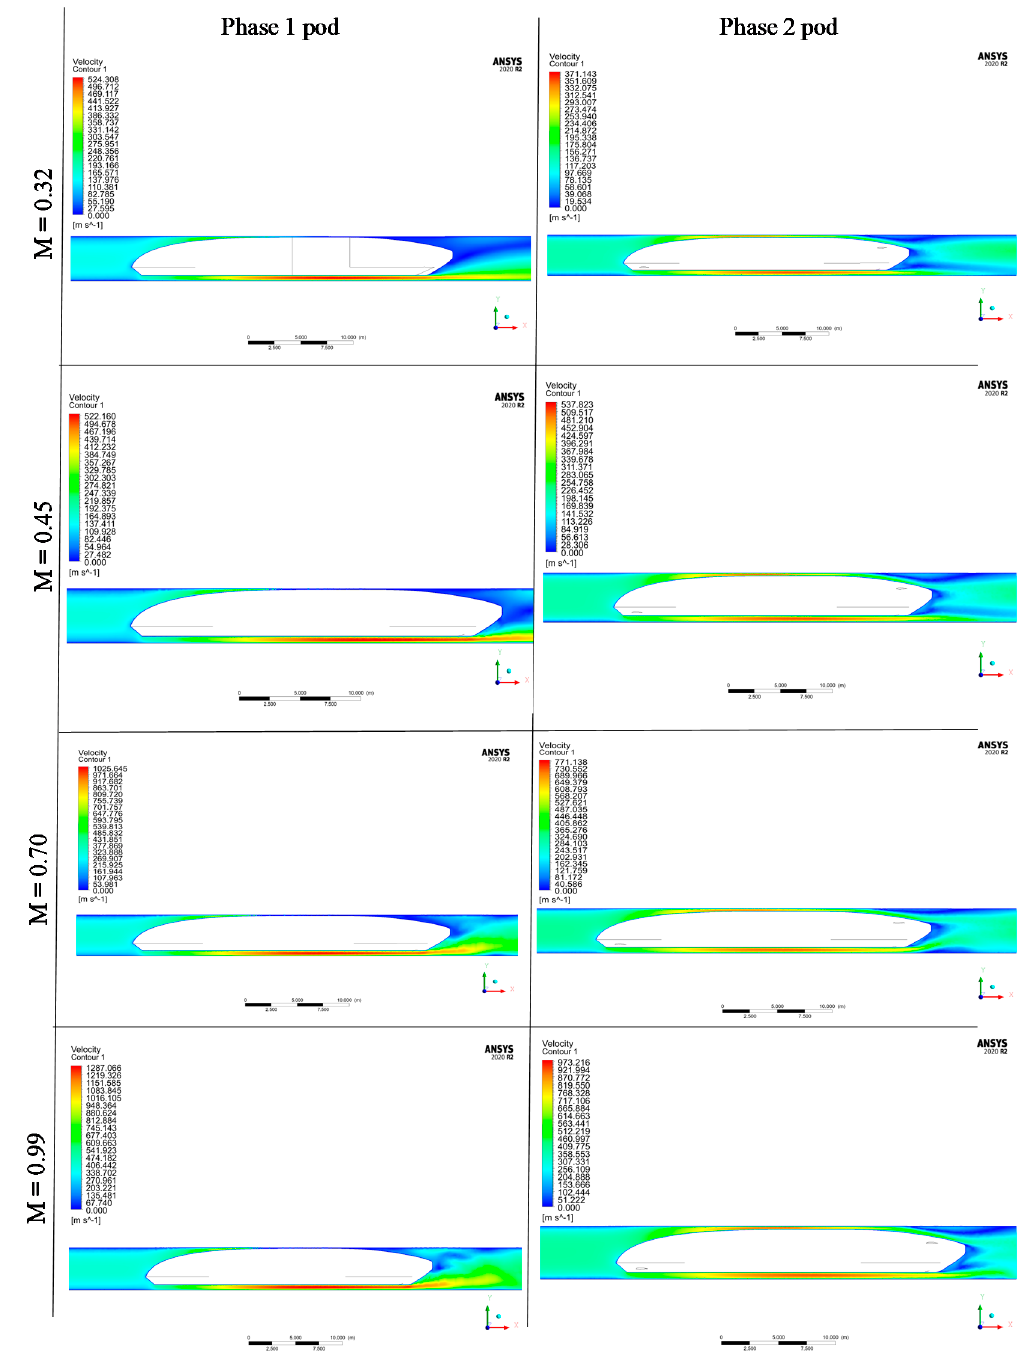
Figure 11. A comparison of the velocity contours around the two pods.